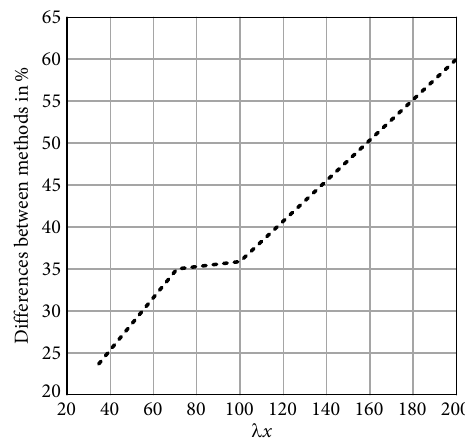
Fig. 8. Difference between the 2 nd and 3 rd situation